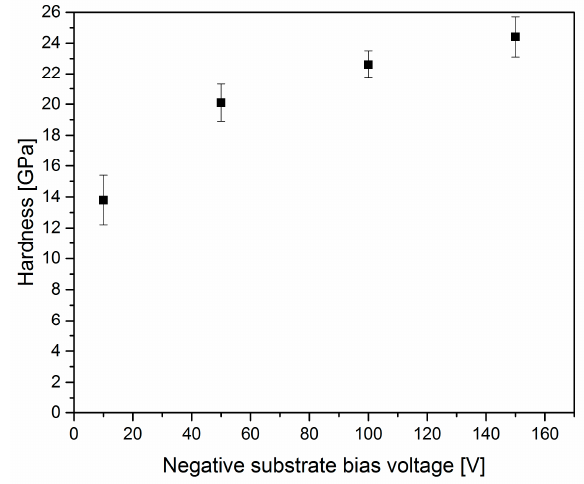
Figure 10. Hardness of AlCrN coatings deposited at temperature of 450 °C and nitrogen pressure of 3 Pa dependent on negative substrate bias voltage.